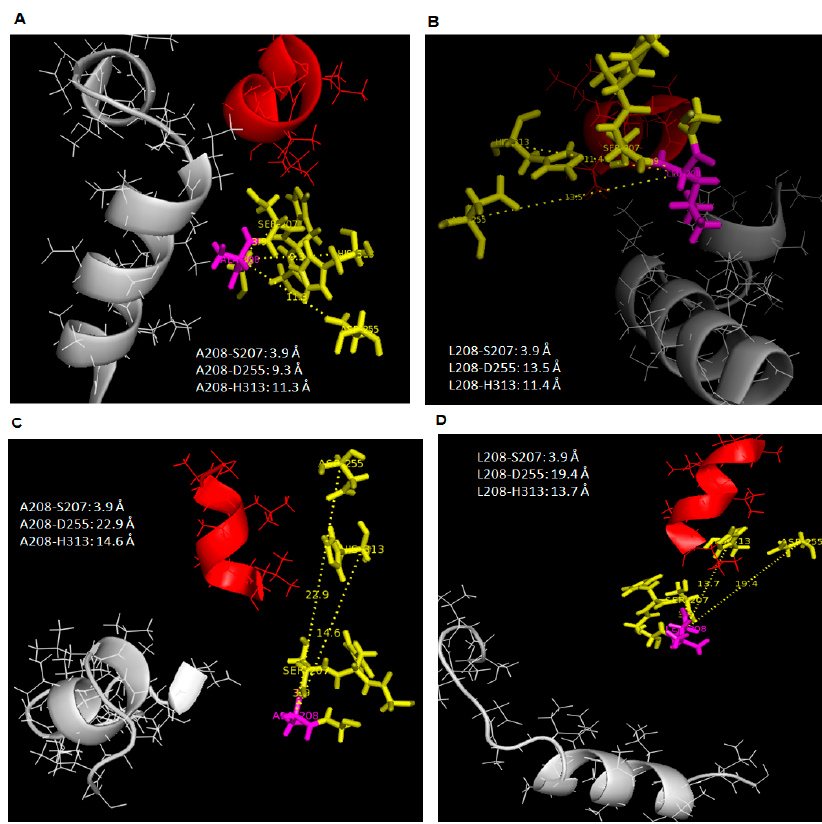
Figure 6. Distance of L208/A208 with catalytic triad S207, D255 and H313 in 35 °C simulation. Image ( A , C ) referred to L208A simulated in water and toluene while ( B , D ) pointed to AMS8 lipase simulated in water and toluene. Lid 1 (51–57) was represented in red helix, lid 2 (148–167) was in grey helix, L208/A208 residue in purple stick and catalytic triads (Ser-207, Asp-255, His-313) were identified as yellow sticks.